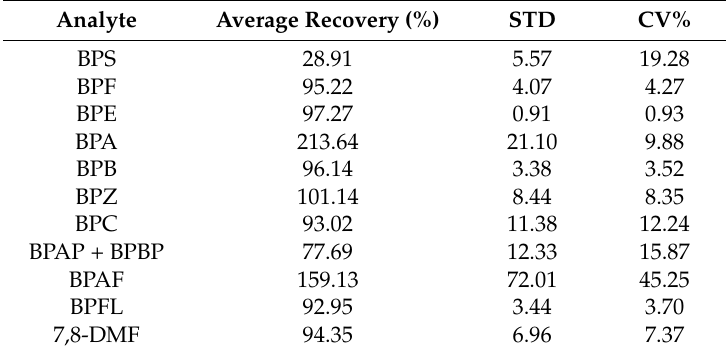
Table 4. Recovery values of bisphenols and internal standard ( n = 5) at concentration corresponding to 100 ng/L and 1 µ g/L (for each bisphenols and IS, respectively) of water sample for the SPE procedure